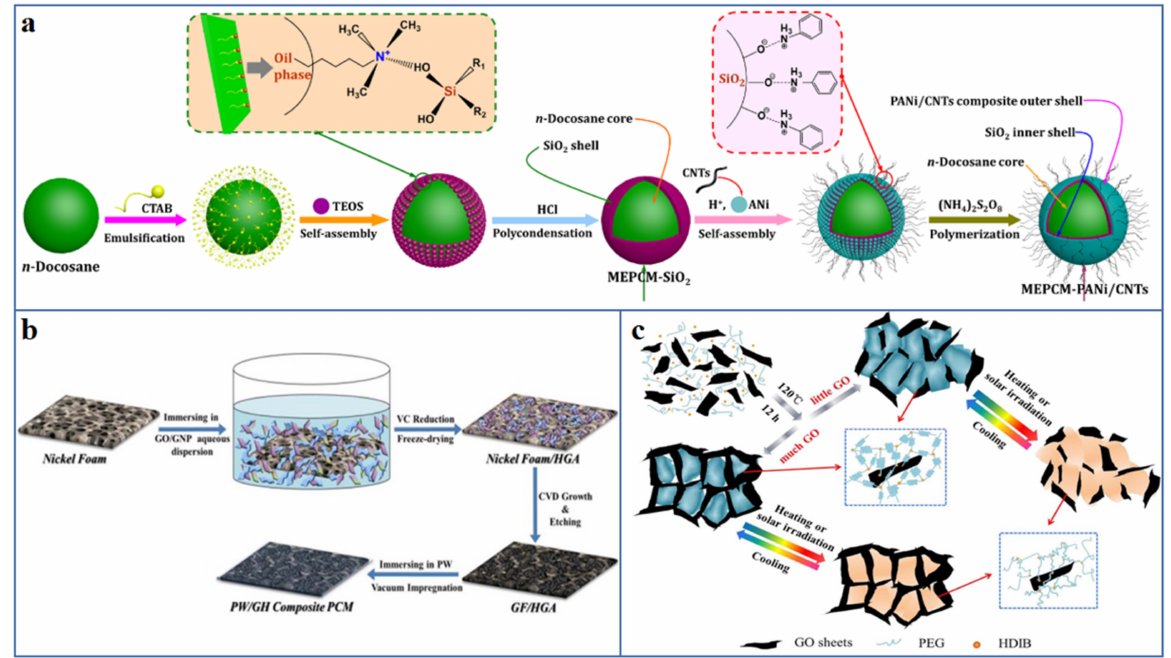
Figure 7. Illustration of preparation of shape-stabilized composite PCM by ( a ) encapsulated methods [110] (Copyright (2020) with permission from Elsevier B.V.), ( b ) introducing supporting material [111] (Copyright (2017) with permission from Elsevier B.V.) and ( c ) fabricating novel solid–solid composite PCM [112] (Copyright (2018) with permission from Elsevier